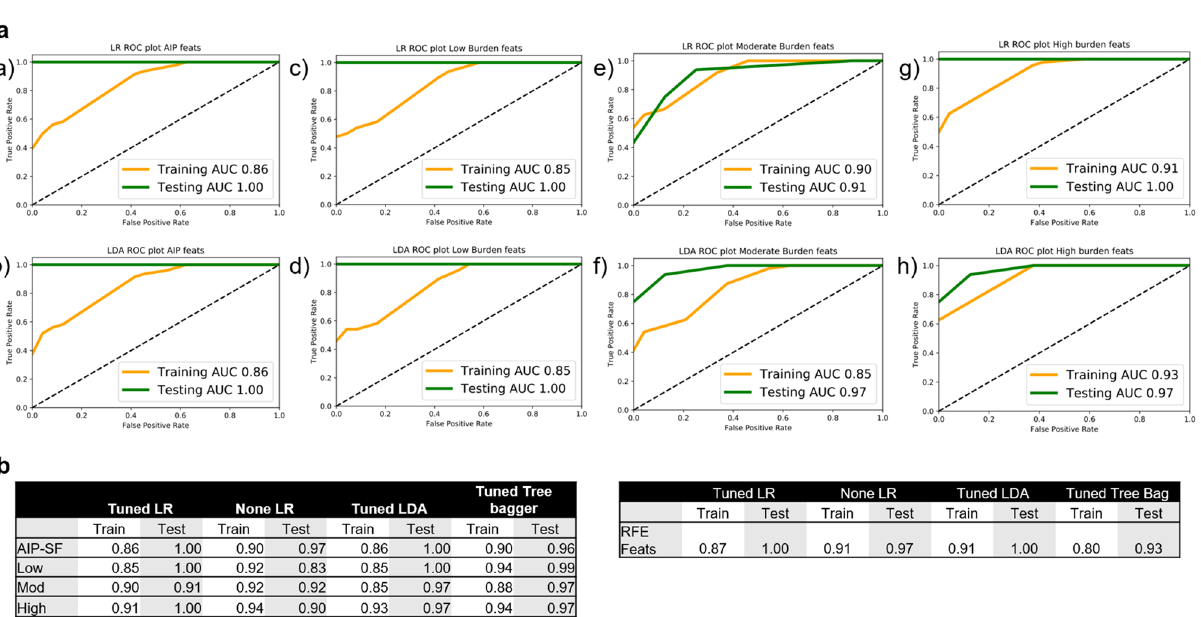
Figure 3. ROC receiver operator characteristic, AUC Area under the curve, LR Logistic regression, LR None logistic regression without hyperparameters, LDA linear determinant analysis, AIP-SF statistically selected average intensity projection image features, Low low burden image feature set, Mod moderate burden image feature set, High high burden image feature set, RFE feats image features common to 3 + tested image feature sets after recursive feature elimination. Overview of models’ performance. ( a ) ROC-AUC plots for LR and LDA models of the four tested image feature sets: (a,b) AIP only features; (c,d) Low burden feature set; (e,f) moderate burden feature set; (g,h) high burden feature set. ( b ) Macro-average AUC scores for four tested image feature sets (left table) and dimensionally reduced feature set (right table) after recursive feature